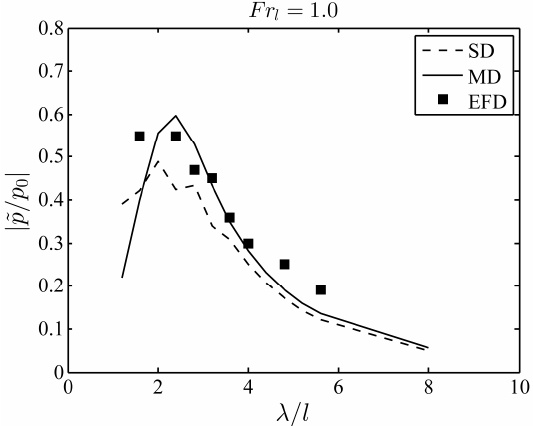
Figure 7. Comparison of fluctuating air pressure RAO of the PACSCAT using the multi-domain and single-domain 2.5D methods with experimental results.